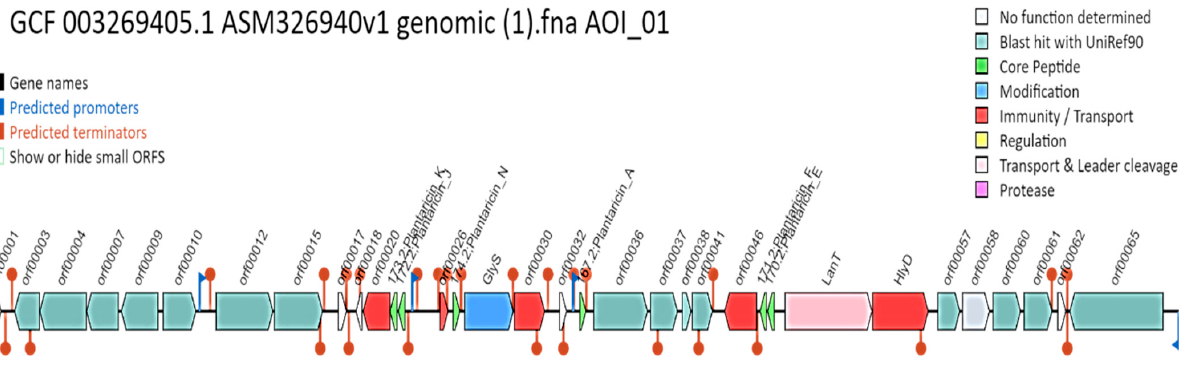
Figure 8. Linear graphical representation of L. plantarum 13 ‐ 3 genome through BAGEL4 showing its non ‐ pathogenic components, i.e., core peptides (green), immunity boosters (red), transportation components (pink), regulatory factors (yellow).